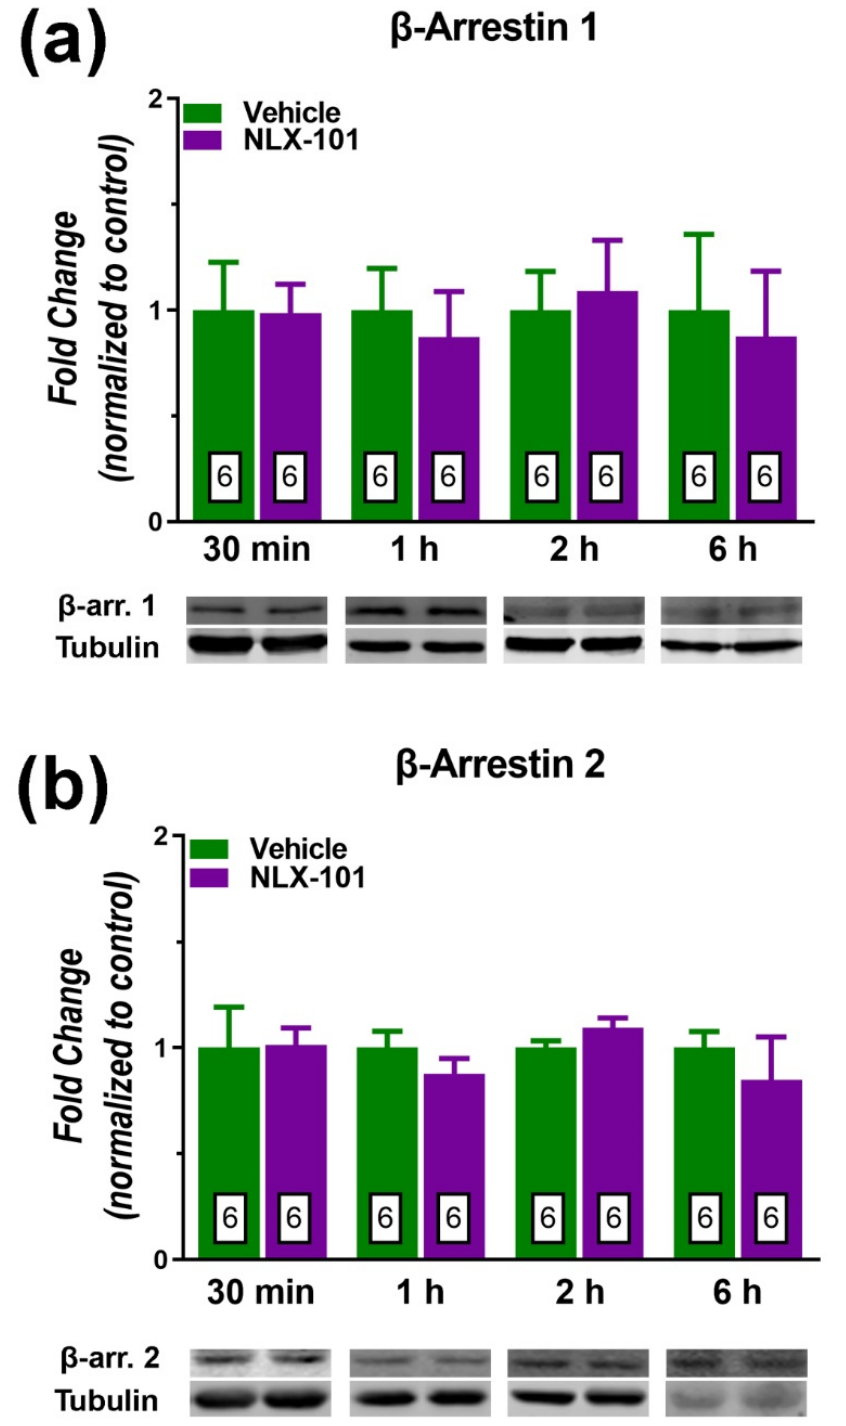
Figure 7. Effects of NLX-101 (0.16 mg/kg) and vehicle (Veh) on the concentration of β -arrestin 1 ( a ) and β -arrestin 2 ( b ) in the prefrontal cortex at 30 min, 1 h, 2 h and 6 h after its intraperitoneal administration. Results are expressed as mean ± SEM. Number of animals is indicated within the bars.